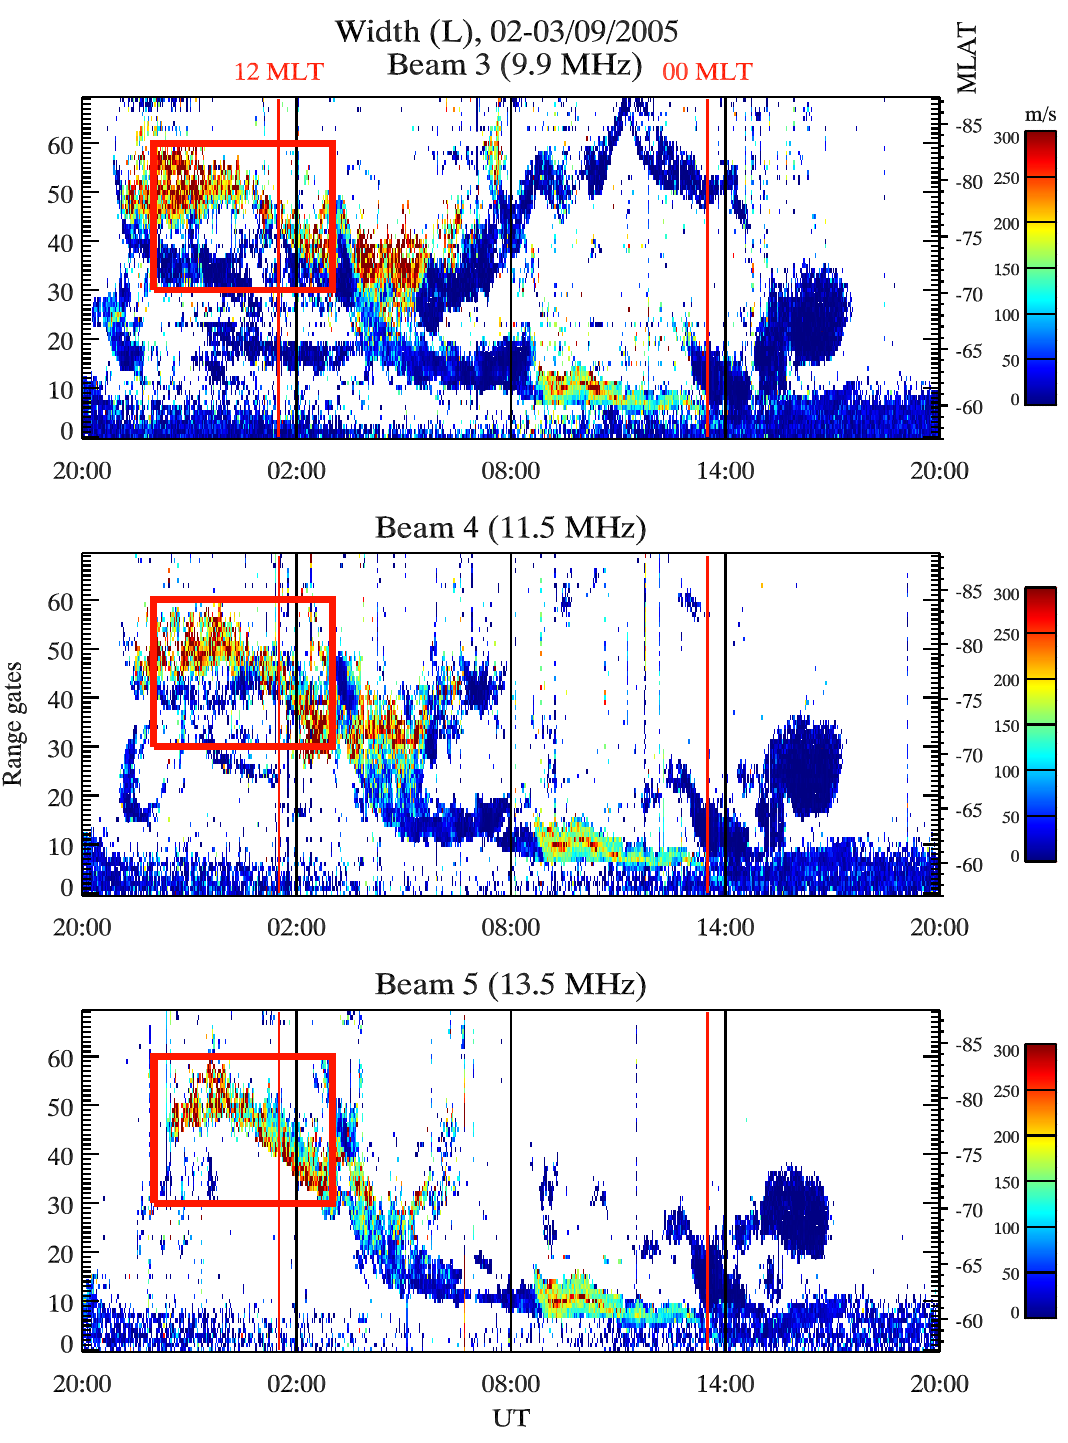
Fig. 2. Example range-time map of TIGER spectral width data during the multi-frequency experiments in September 2005. Probe frequency increases from top to bottom. The red rectangle encloses large- W F-region scatter data anlysed later in this section.